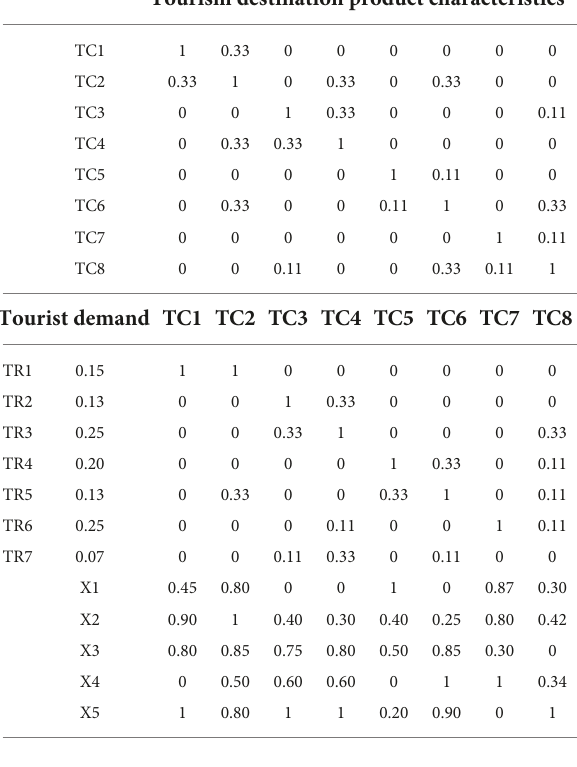
TABLE 4 The quality of psychological expectation assessment of tourists in the class